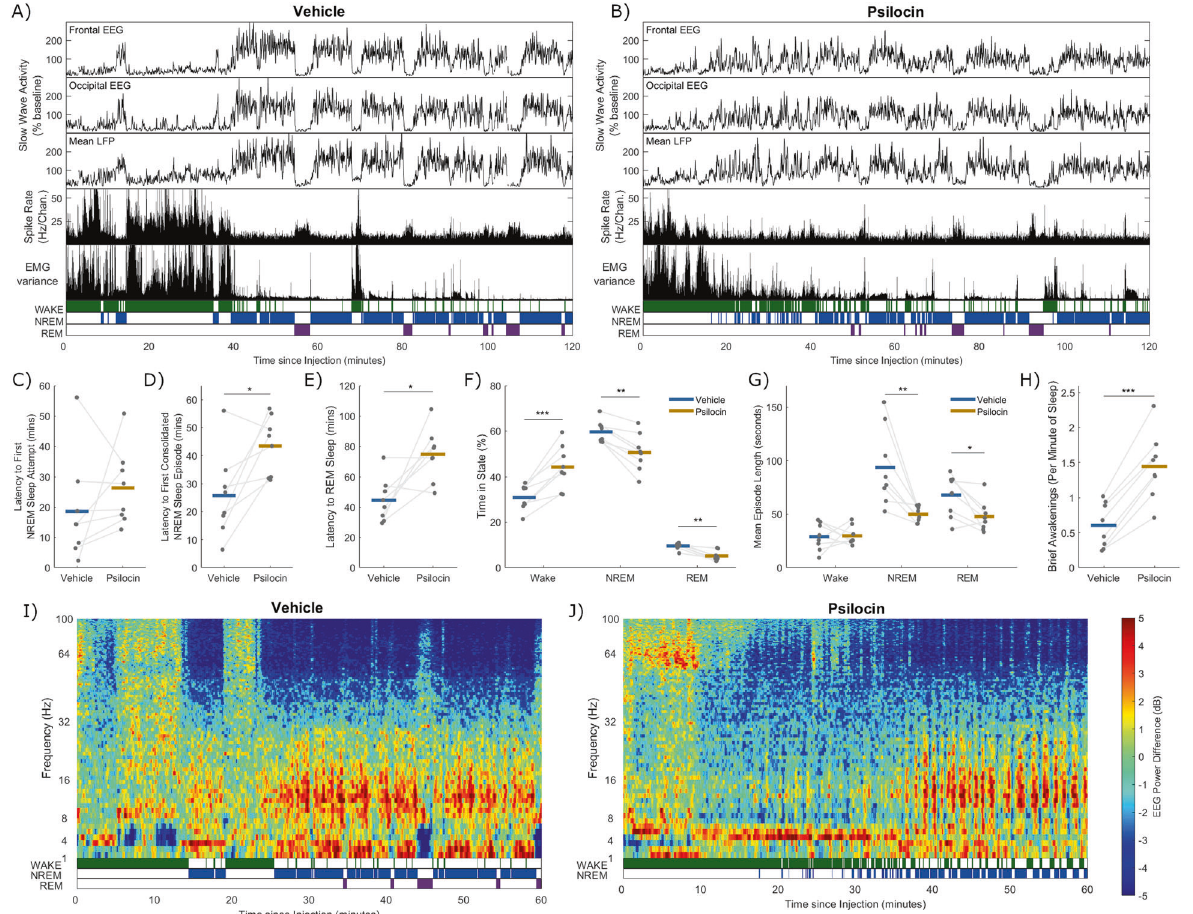
Fig. 2 Acute disruption of sleep-wake behaviour and brain activity by psilocin. A representative example of slow-wave activity (0.5 – 4 Hz power) derived from frontal electroencephalogram (EEG), occipital EEG, and mean local fi eld potential (LFP), alongside the total recorded spike fi ring rate (spikes per second per channel), variance of the electromyogram (EMG) and scored vigilance states, all with a resolution of 4 seconds over a period of 2 h after A ) injection with vehicle, and B ) injection with psilocin, in the undisturbed condition. The latency in minutes from injection C ) until the fi rst 4-second epoch scored as NREM sleep, D ) until the fi rst continuous NREM sleep episode at least 1-minute duration, and E ) until the fi rst 4-second epoch scored as REM sleep. F ) The percentage of the three-hour period after injection which was scored as wake, NREM or REM sleep, and G ) the mean length in seconds of wake, NREM and REM sleep episodes in this time. H ) The number of brief awakenings (wake episodes < 20 seconds occurring within NREM episodes at least 1-minute duration) per minute of NREM sleep during the fi rst hour after injection. In C-H ) grey dots correspond to individual animals, with grey lines linking values from the same animal, coloured lines indicate the group mean for vehicle (blue) and psilocin (yellow) conditions and asterisks denote statistical signi fi cance with a paired t-test; *: p < 0.05, **: p < 0.01, ***: p < 0.001. Time-frequency plots characterising changes in frontal EEG spectral power (in decibels relative to power averaged over the baseline day) over the fi rst hour after injection with I ) vehicle and J ) psilocin, from one representative example (different animal to A & B